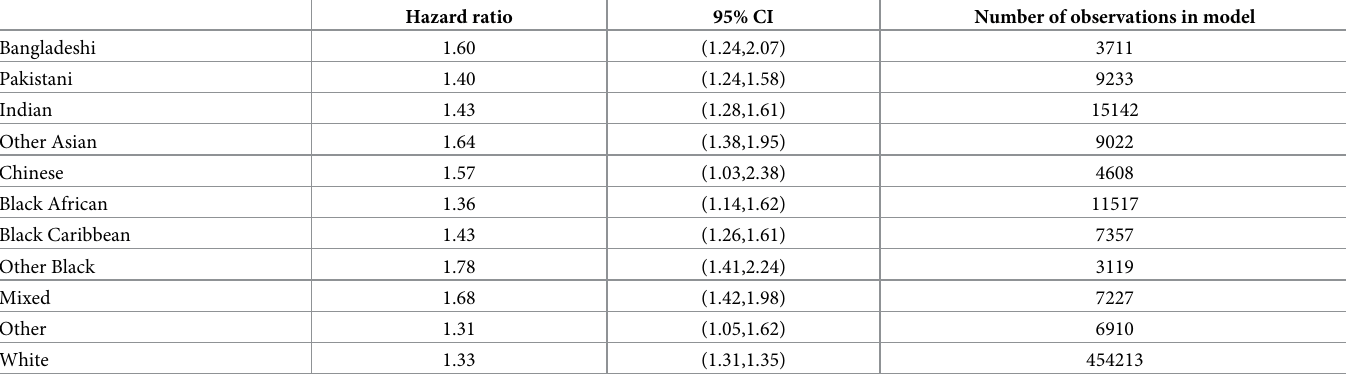
Table 3. Mortality hazard ratio per additional condition from ethnicity-stratified models estimated at age 50 (examining whether ethnicity moderates the associa- tion between total number of LTCs and survival).